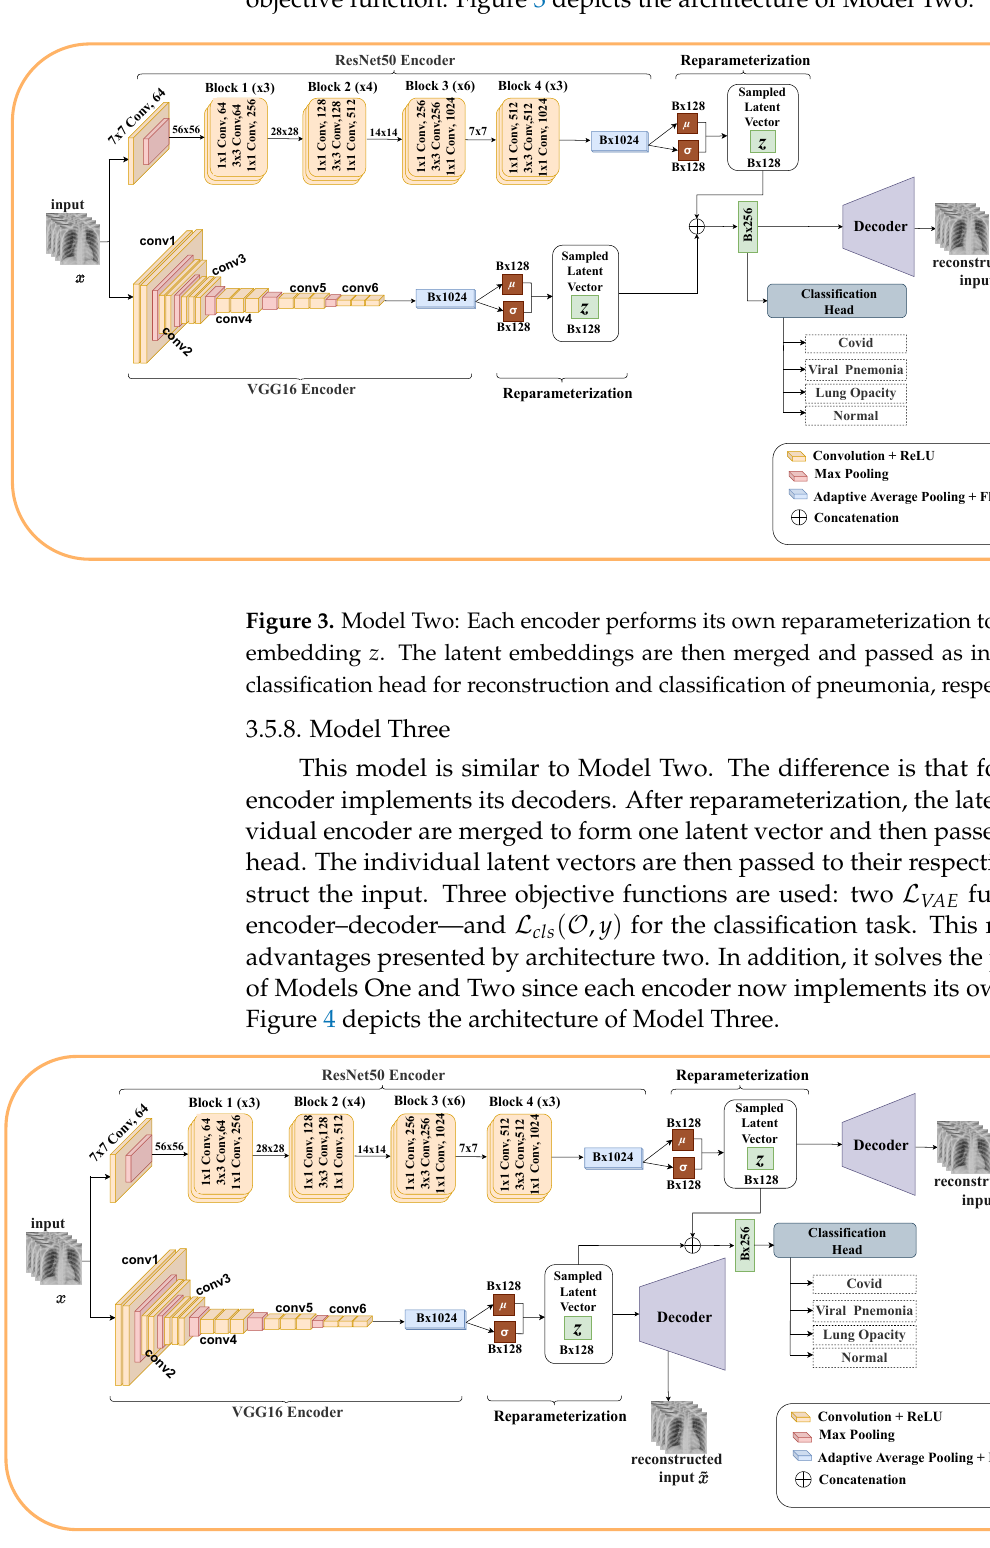
Figure 4. Model Three: Each encoder performs its own reparameterization to generate its own latent embedding z . The latent embeddings are passed to their respective decoders for reconstruction of the input image and then merged and passed as input to the classification head for classification of